Question: What direction does the quantity move in — increasing or decreasing?
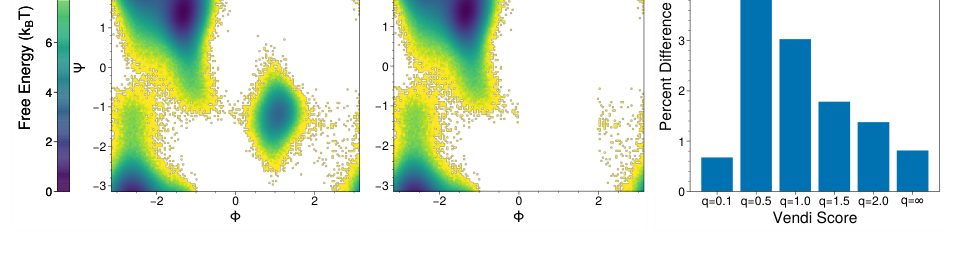
Answer: increasing